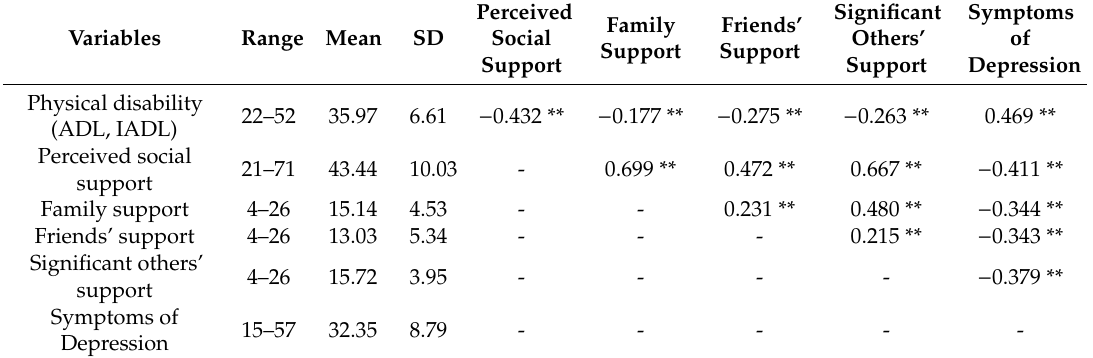
Table 2. Descriptive statistics and Pearson correlation analysis.